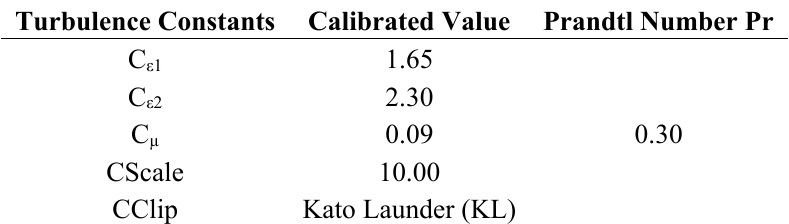
Table 4. Calibrated parameters for k - ε